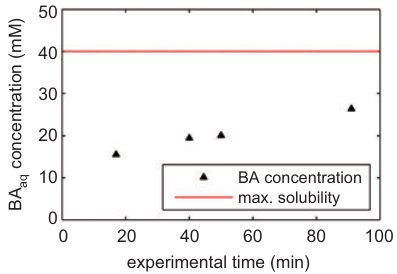
membrane. Membrane parameters: hydrophobic PVDF membrane, d = 700 μ m, pore diameter 0.1 μ m, area 165 mm 2 . Experimental i